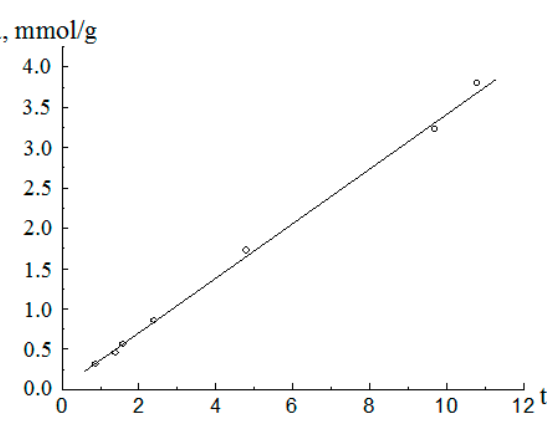
Figure 5. t-graf for the adsorption ( ○ ) isotherm for methanol vapors on the aluminum oxide material.